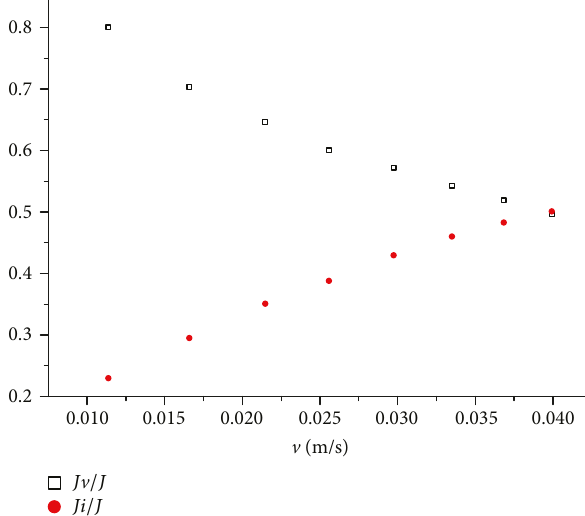
Figure 4: The relationship of Jv / J and Ji / J versus v .